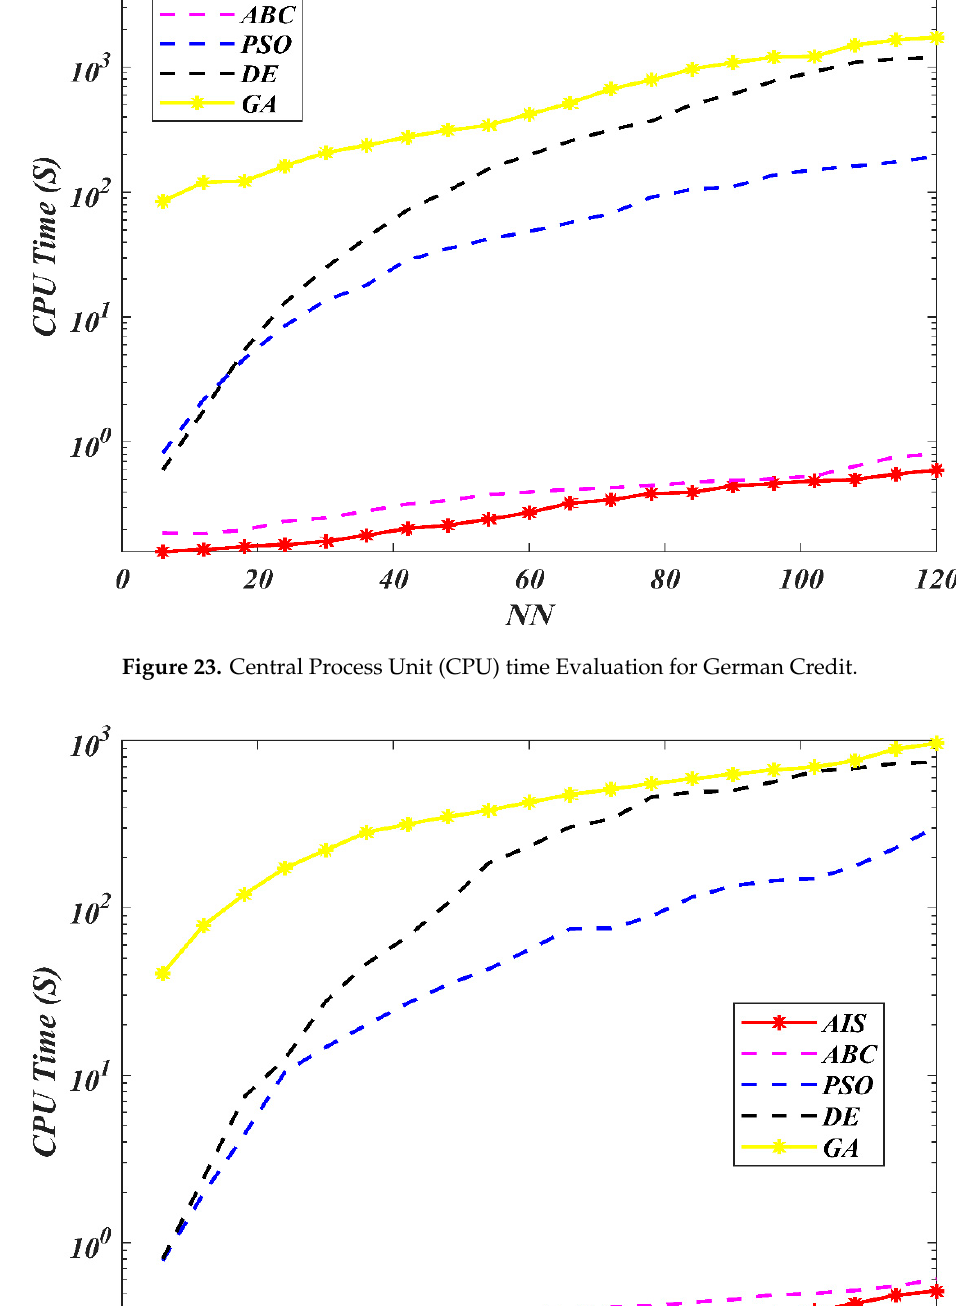
Figure 22. SBC Evaluation for Postoperative Patient.